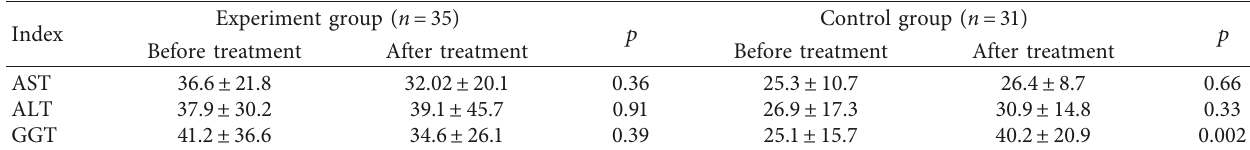
Table 6: AST, ALT, and GGT before and after treatment of the two